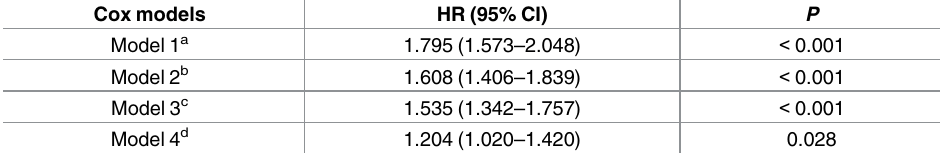
Table 2. Adjusted hazard ratios for the association between hypoalbuminemia and development of acute kidney injury. Cox